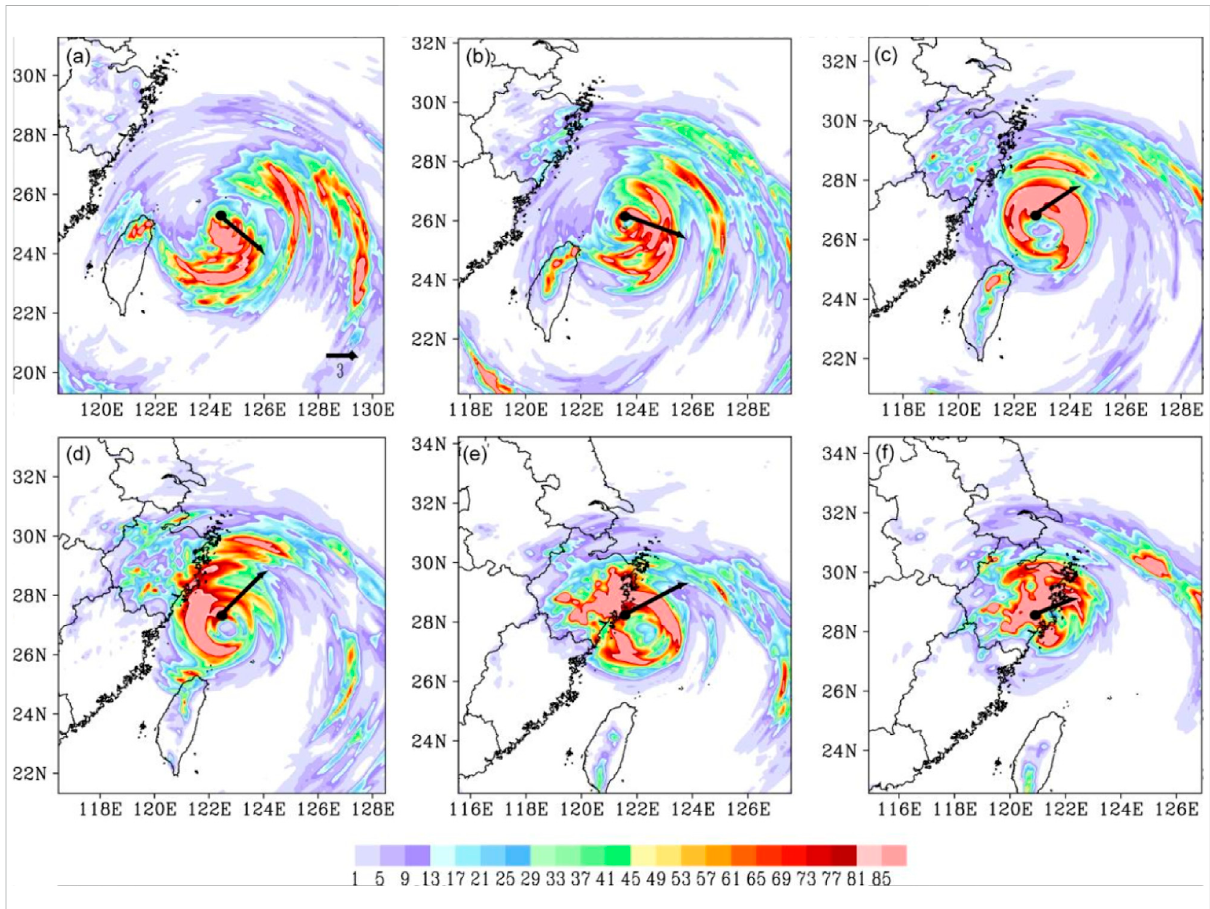
FIGURE 4 Simulated 6-h accumulated precipitation (unit: mm) at (A) 18:00 UTC on 8 August, (B) 00:00 UTC on 9 August, (C) 06:00 UTC on 9 August, (D) 12:00 UTC on 9 August, (E) 18:00 UTC on 9 August, and (F) 00:00 UTC on 10 August 2019 in the CTL experiment. The black arrow denotes VWS between 200 and 850 hPa, with black dots indicating the center of